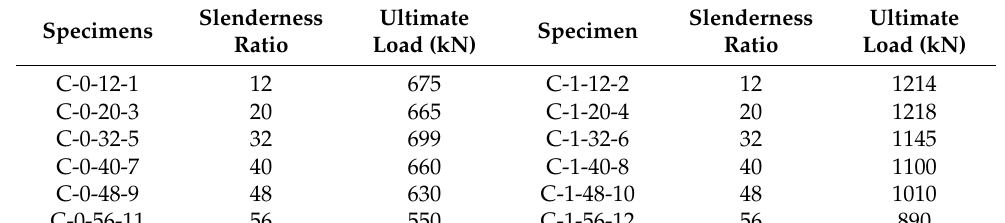
Table 3. Summary of test results.